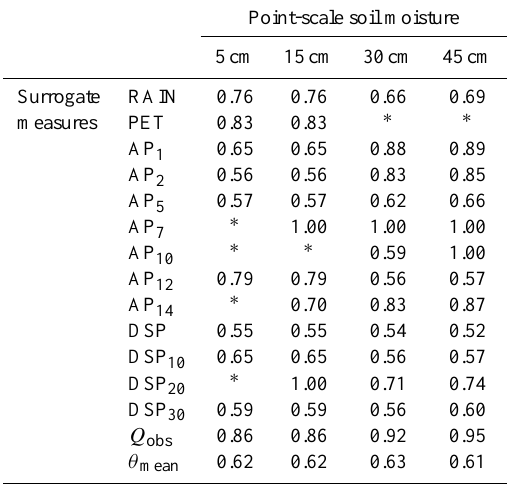
Table 3. Catchment-wide average of Akaike weights or probabili- ties associated with the best mathematical model chosen to illustrate the relationships between point-scale soil moisture content and sur- rogate